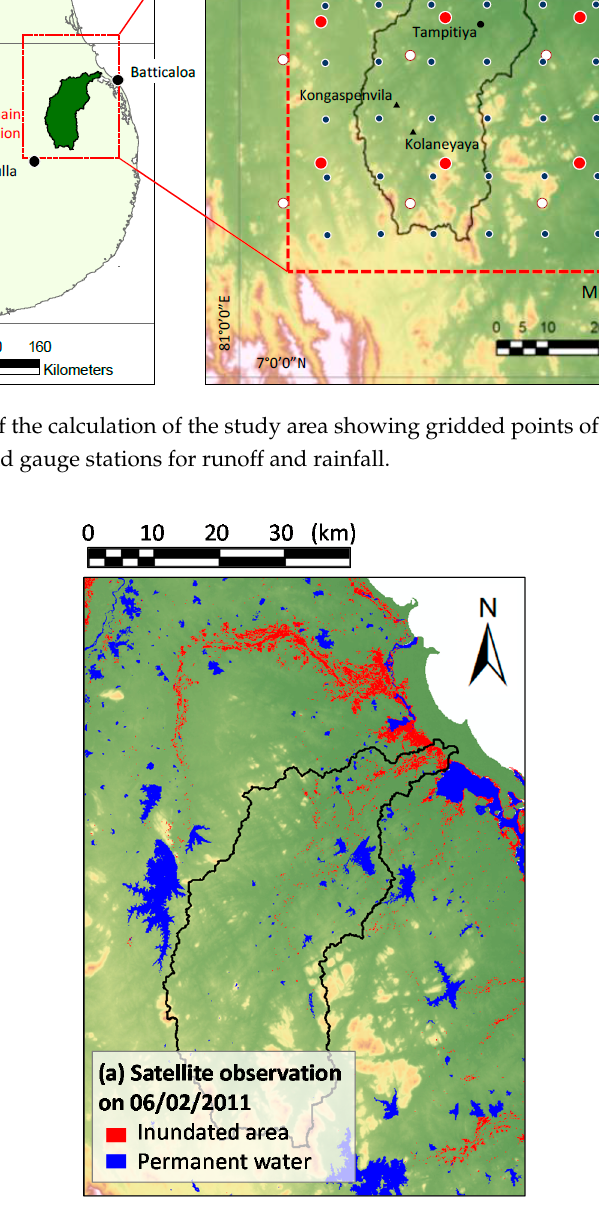
Figure 2. Inundation extent of a flood in January and February 2011, analyzed by satellite observation images [26].